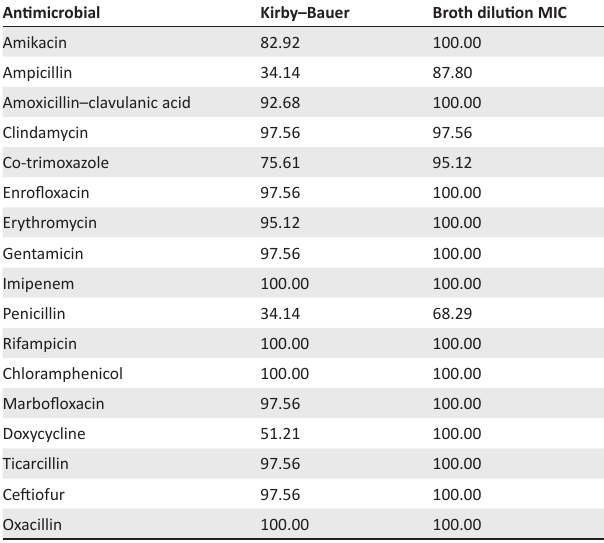
TABLE 2: Comparison of percentage antimicrobial susceptibility as indicated by Kirby–Bauer and broth dilution minimum inhibitory concentration data for the period 2007–2010.